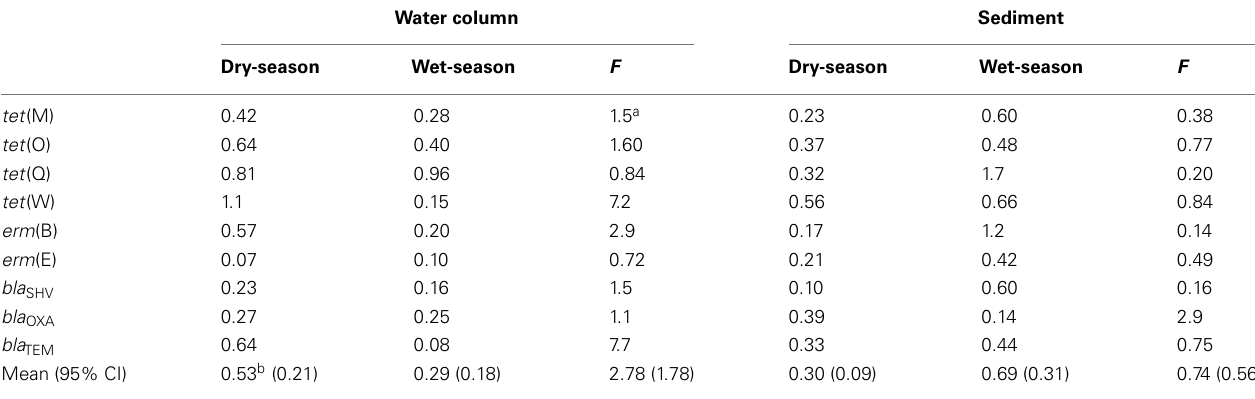
Table 2 | Interstation variability of measured sediment and water columnARG abundances during dry-season and wet-season sampling.